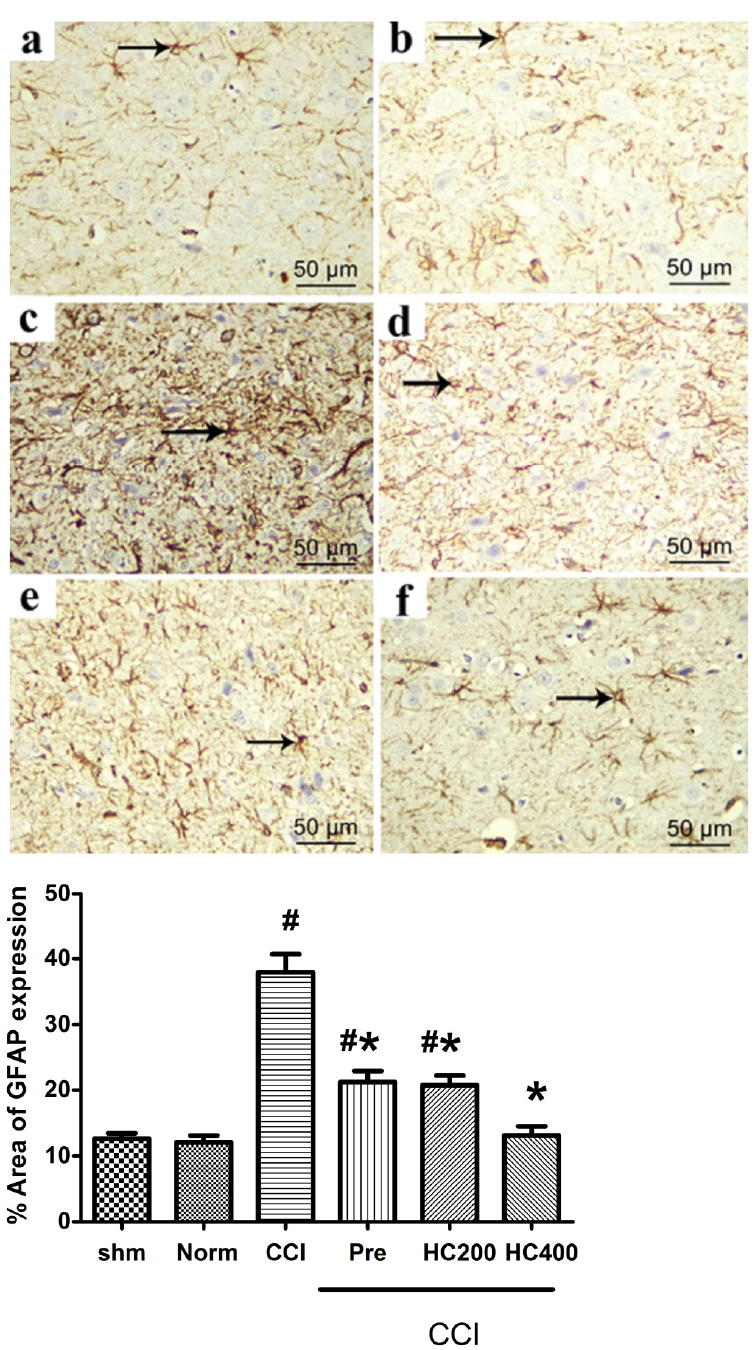
Figure 12. Photomicrographs of the brain stem of the normal ( a ), sham ( b ), control (CCI) group ( c ), pregabalin group ( d ), H. campechianum flower extract (p.o., 200 mg / kg) ( e ); and H. campechianum flower extract (p.o., 400 mg / kg) ( f ) groups. Bar chart demonstrating the area % of GFAP positive astrocyte in the brain stem of the di ff erent experimental groups. Statistical analysis was carried out using one-way ANOVA, followed by Tukey’s post hoc test. Values are represented as the mean ± SEM (n = 8). # significant di ff erence compared to the control group, p < 0.05. * Significant di ff erence compared to the diseased group, p <